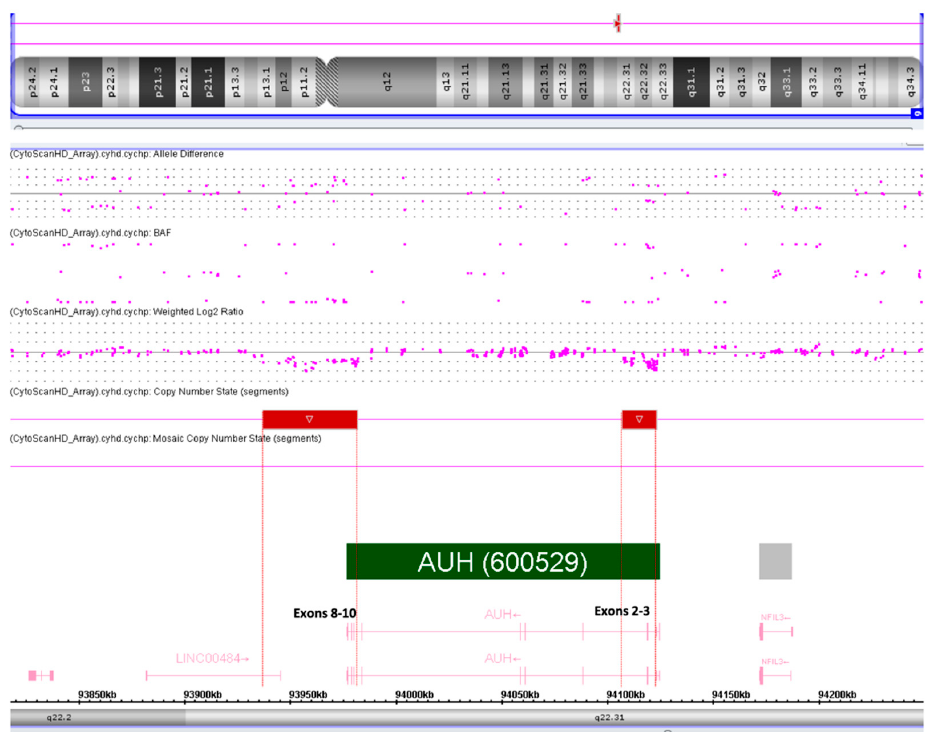
Figure 2. Single nucleotide polymorphism array profile of the 9q22.31 region showing the two losses (red bars and dotted red lines) involving exons 8–10 and 2–3 of the AUH gene in the 9q22.31 region. The same analysis also disclosed a maternally inherited microduplication at 1p36.33 that included the following genes: FNDC10, LOC105378586, ATAD3C, ATAD3B, SSU72, ATAD3A, and TMEM240, though its clinical significance is currently unknown. Copy number variation (CNV) analysis performed on patient and parental samples confirmed the presence of the two deletions in compound heterozygosity, with the 45 Kb deletion present in the maternal sample and the 16 kb deletion inherited from the father (Figure 3).